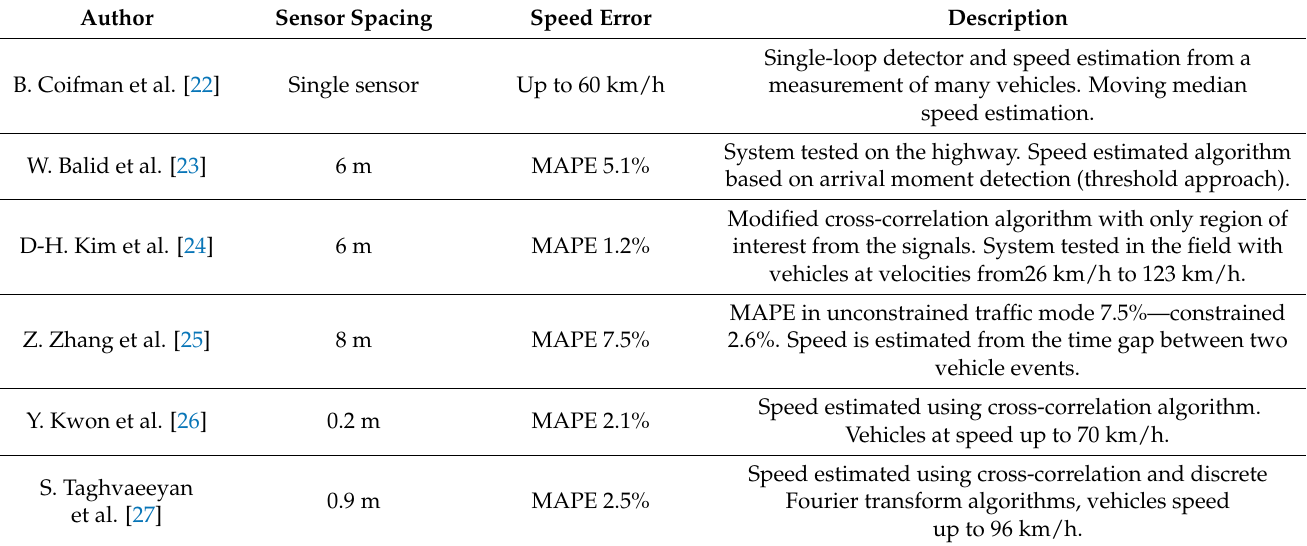
Table 1. Speed estimation result comparison with magnetic field